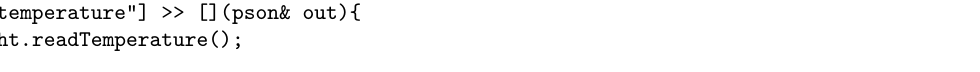
Figure 13. Read a sensor value.